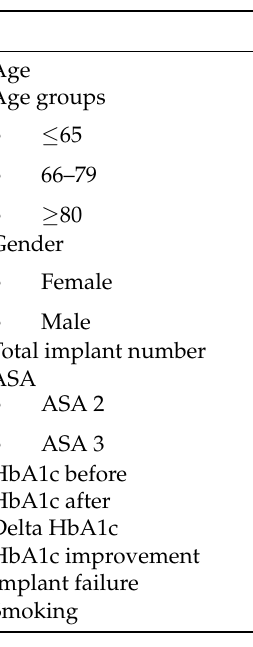
Table 1. Demographic and clinical characteristics (individual